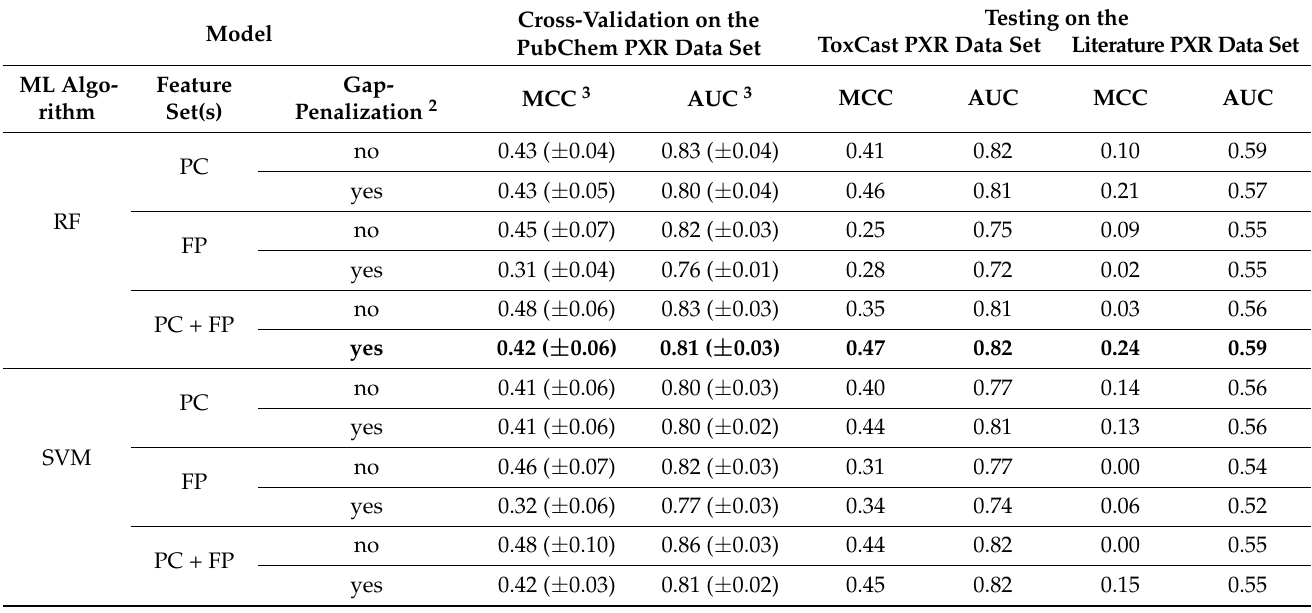
Table 3. Performance of Different ML Models and Feature Sets. 1